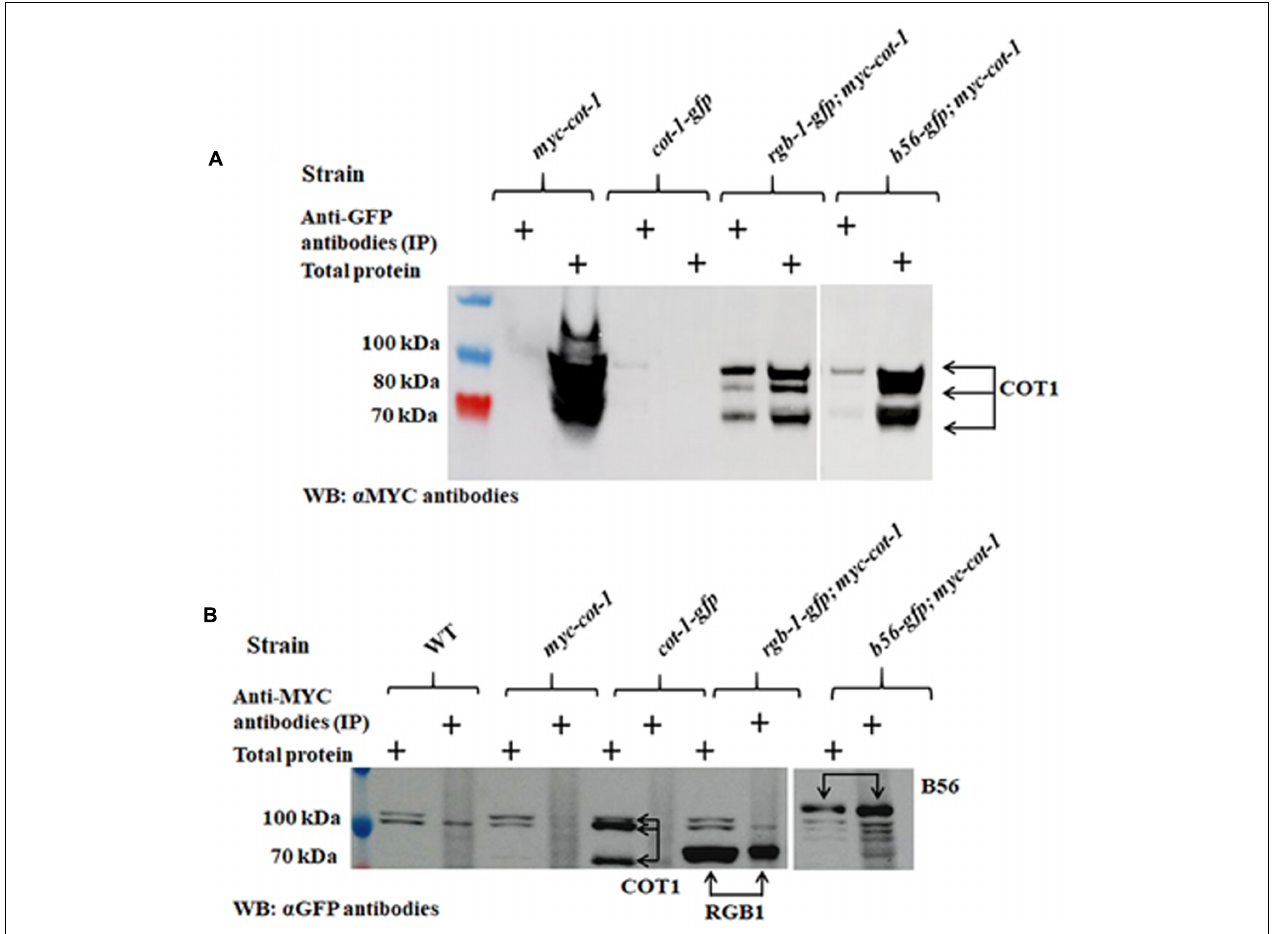
FIGURE 11 | The PP2A regulatory subunits RGB1 and B56 physically interact with COT1. (A) Detection of COT1 in total protein extracts and those immunoprecipitated with anti-GFP antibodies and probed with anti-MYC antibodies. Arrows indicate the detected COT1 forms. (B) Detection of COT1 in total protein extracts and those immunoprecipitated with anti-MYC antibodies and probed with anti-GFP antibodies. Arrows indicate the detected the chimeric forms of COT1, RGB1, and